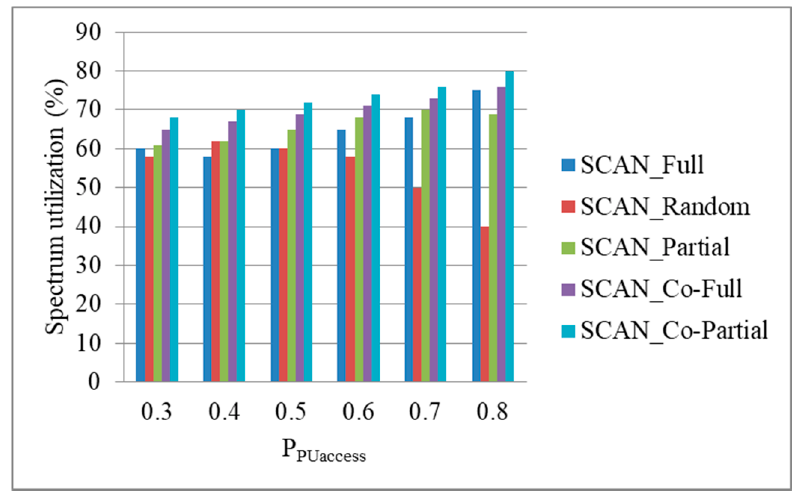
Figure 15. Spectrum utilization ratio under different primary user (PU) cars access network probabilities (PU number = 10, V = 10, SU number = 10).